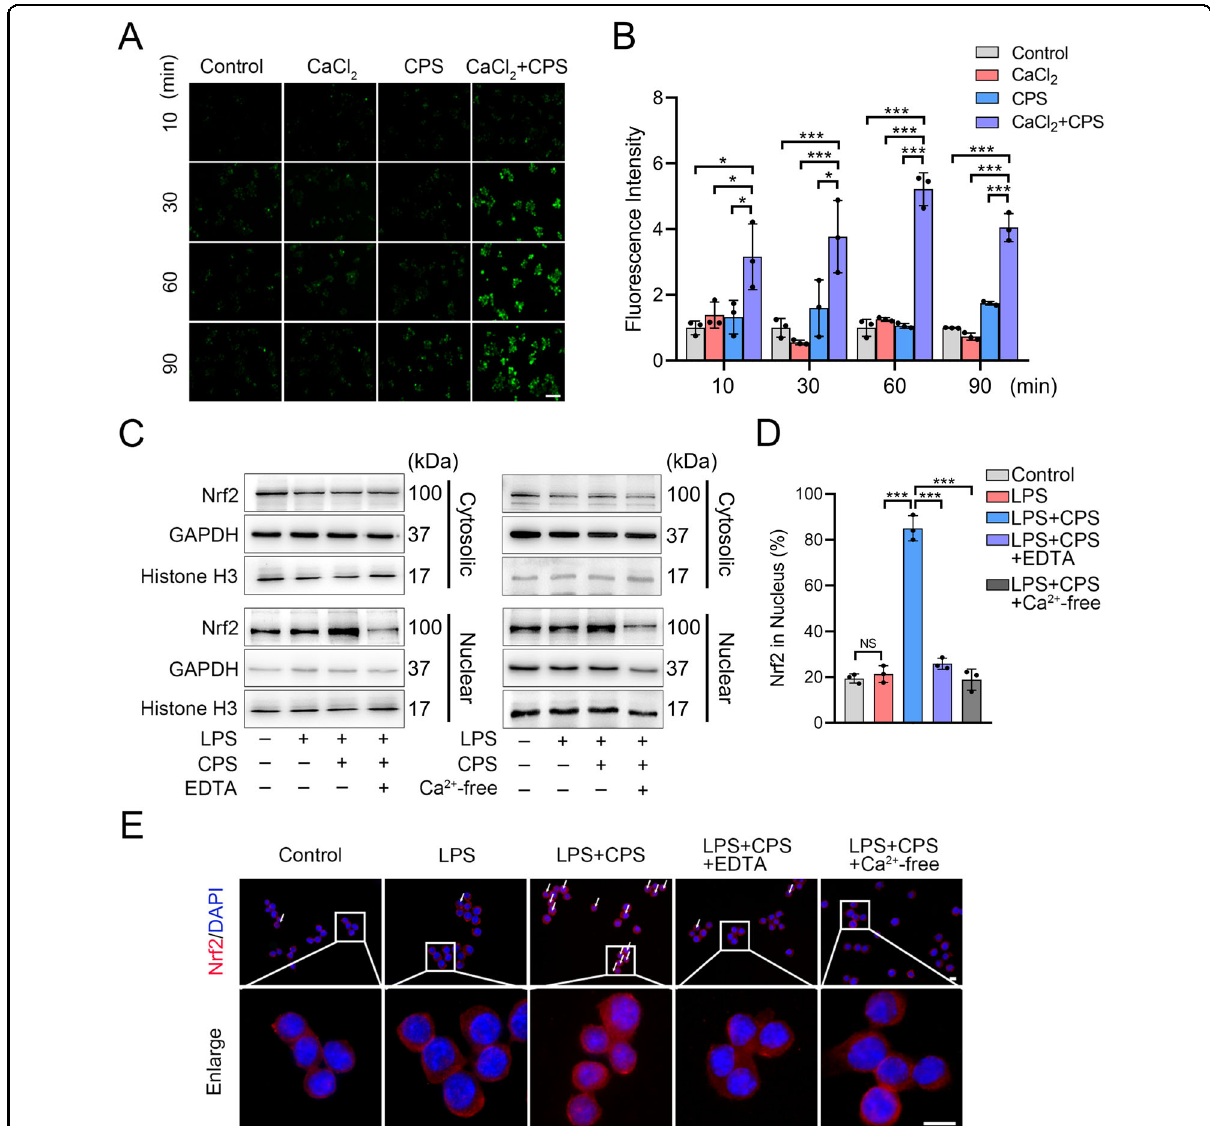
Fig. 5 TRPV1-mediated Ca 2 + in fl ux promotes Nrf2 nuclear translocation in RAW264.7 cells. A Fluorescence images and B their quantitative analysis of intensity in the Fluo-4 AM-loaded RAW264.7 cells treated with CaCl 2 , CPS, or CaCl 2 + CPS under the Ca 2 + -free medium for 10, 30, 60, and 90 min. Scale bars: 50 μ m. C Western blot analysis of cytosolic and nuclear Nrf2 protein levels in the cells treated with LPS, LPS + CPS, and LPS + CPS with EDTA (left) or Ca 2 + -free medium (right) for 3 h. D Quantitative analysis and E representative images of Nrf2 immuno fl uorescence in the cells treated with LPS, LPS + CPS, and LPS + CPS with EDTA or Ca 2 + -free medium for 3 h. Scale bars: 10 μ m. White arrow: cells with Nrf2 nuclear translocation. Data ( n = 3) are shown as mean ± SD. * P < 0.05; *** P < 0.001; NS nonsigni fi